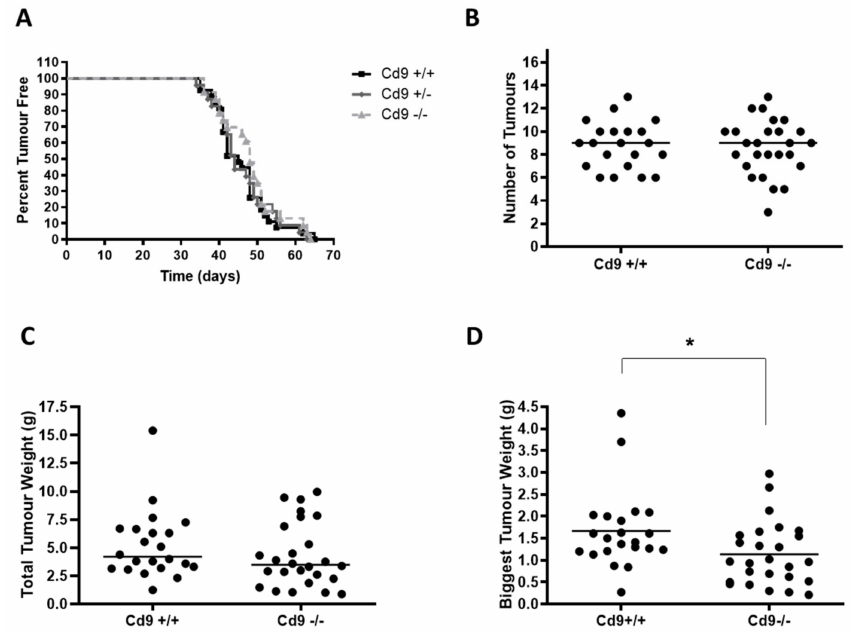
Figure 5. PyMT tumor growth is impaired in Cd9 − / − mice, with no change in tumor onset. ( A ). Kaplan–Meier kinetic analysis of tumor occurrence in PyMT Cd9 − / − ( n = 23) , Cd9 +/ − ( n = 23) and Cd9 +/+ (n = 27) mice. In order to assess the e ff ect of Cd9 deletion on tumor initiation, mice were palpated twice a week to detect tumor onset. ( B ). PyMT tumors were analyzed at 14 weeks of age in PyMT Cd9 +/+ and Cd9 − / − mice and the total number of tumors per mouse was counted. ( C ). Total tumor weight was measured at 14 weeks of age in PyMT Cd9 +/+ and Cd9 − / − mice. ( D ). The weight of the biggest tumor was measured and compared between Cd9 − / − and Cd9 +/+ mice; * p = 0.02.